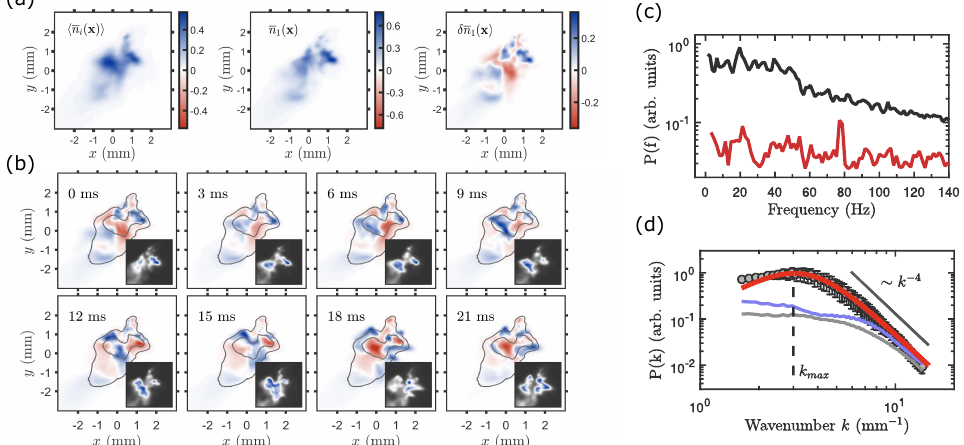
Figure 2. (Colour online.) ( a ) Exemplification of column density maps. From left to right: average density profile, column density at 0ms, fluctuating column density at 0ms—see Appendix B for further clarification. ( b ) Time evolution of the fully developed turbulent phase. The plots depict the fluctuating column density; the grey contours represent the average density profile. The inset shows the original column density without the subtraction of the average density profile. ( c ) Power spectrum of the atom density fluctuations (time domain), in the quasi-static photon bubble phase (red line) and in the regime of photon bubble turbulence (black line). ( d ) Experimental (spatial) power spectrum of the atom density fluctuations in the fully developed PBT regime (grey dots) and numerical fit to the theoretical power spectrum (red line). The black line indicates the k − 4 decay tail, evidence of the presence of well-defined dynamical structures. The blue and grey lines correspond to transient situations in the range δ > − 0.6 Γ , and depict the transition into the fully developed turbulent